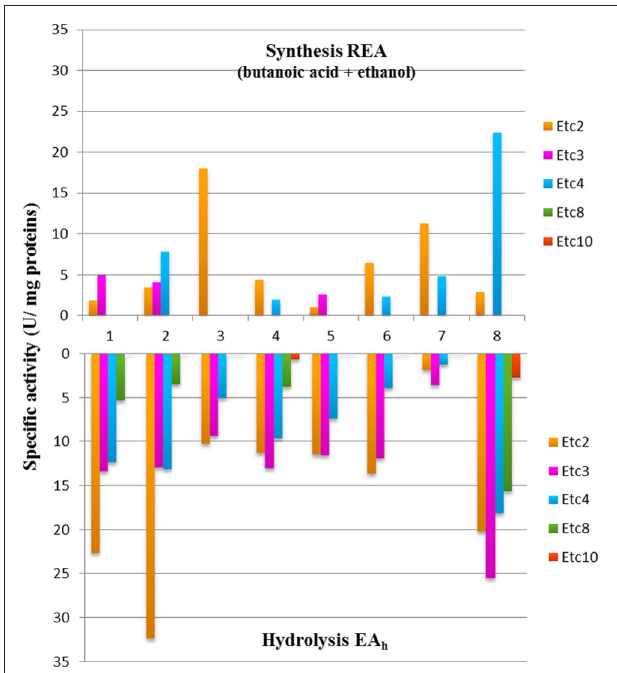
FIGURE 4 | Esterase activity of biosynthesis and hydrolysis of ethyl esters by 8 LAB strains. 1 , Lc. lactis FMy2-21-2; 2, Lc. lactis FN3-317; 3, W. minor G1-E-19; 4, Leuc. mesenteroides FMy-1-2; 5, Leuc. mesenteroides F-G1-7; 6, Leuc. pseudomesenteroides F30-G1-38; 7, Lb. brevis F-G2-31; and 8, Lb. rhamnosus